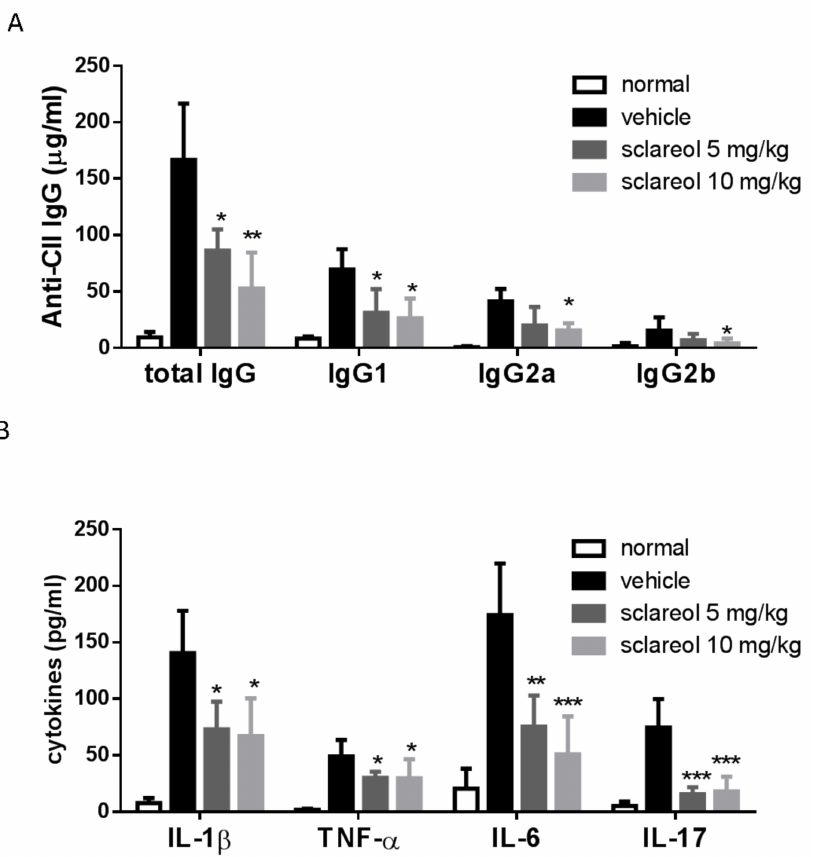
Figure 3. Effects of sclareol on anti-collagen II (anti-CII) IgG specific autoantibodies and serum cytokine levels. Serum obtained from each group on day 42 was measured for ( A ) anti-mouse collagen II IgGs and ( B ) pro-inflammatory cytokines by ELISA. Values on the graph represent the means ± SD from six mice/group. * p < 0.05, ** p < 0.01, and *** p < 0.001 versus vehicle-treated CIA